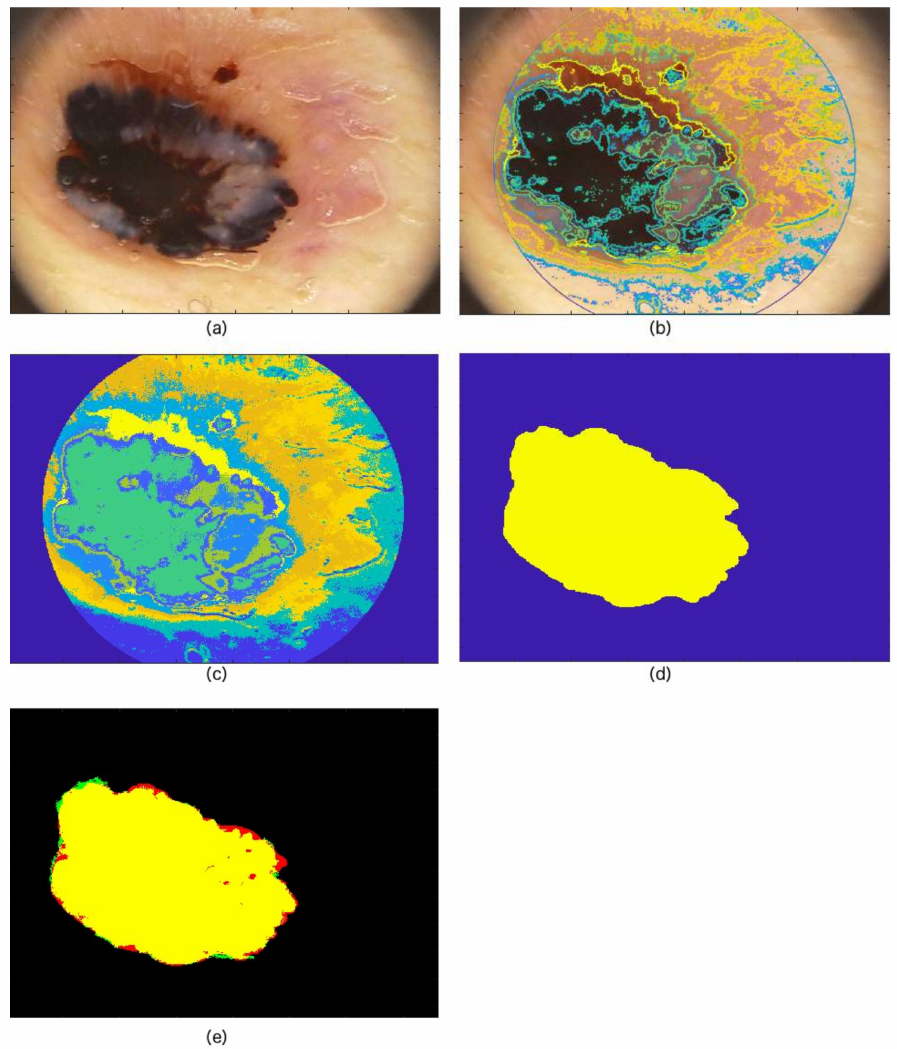
Figure 2. Results of the various steps implemented in the segmentation block. ( a ) Image of the database being tested, ( b ) ROI localization and detected borders of the coherent color areas, ( c ) segmentation into coherent color areas, ( d ) ground-truth provided by the dataset, ( e ) comparison by overlapping between the ground-true and the obtained segmentation (green: the segmentation performed by the procedure, red: ground-truth, yellow: overlapping